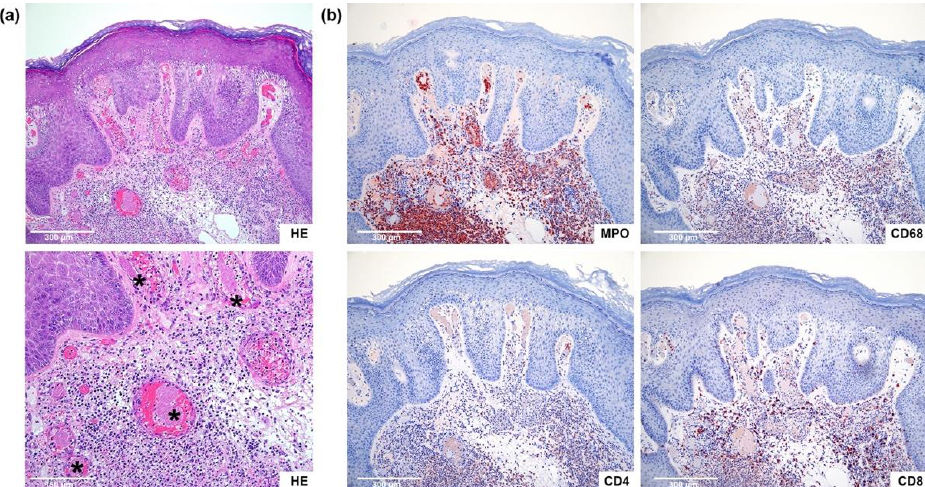
Figure 2. ( a ) Histology confirms microthrombosis in warts 8 h after treatment with ingenol mebutate (IM). The wart of patient 6 is shown as an example. Both within the capillaries and the postcapillary venules fibrinoid thrombi (*) could be detected, surrounded by sludge of erythrocytes. The postca- pillary venules showed a strong diapedesis of neutrophils with extravasated erythrocytes and some distinct leukocytoclasia around the vessels, proving signs for vasculitis were missing. (Hematoxylin and Eosin (HE) staining; original magnification top 100×, bottom 200×); ( b ) immunohistochemistry showed a neutrophil- dominated inflammatory infiltrate after 8 h. Again, patient 6′s wart is shown as an example at timepoint 8 h. The inflammatory infiltrate consisted mainly of MPO-positive neu- trophils, but also CD68-positive macrophages, CD8-positive cytotoxic T cells, and CD4-positive T helper cells were recruited. (Immunohistochemical staining with MPO, CD68, CD4, CD8; original magnification 100×).